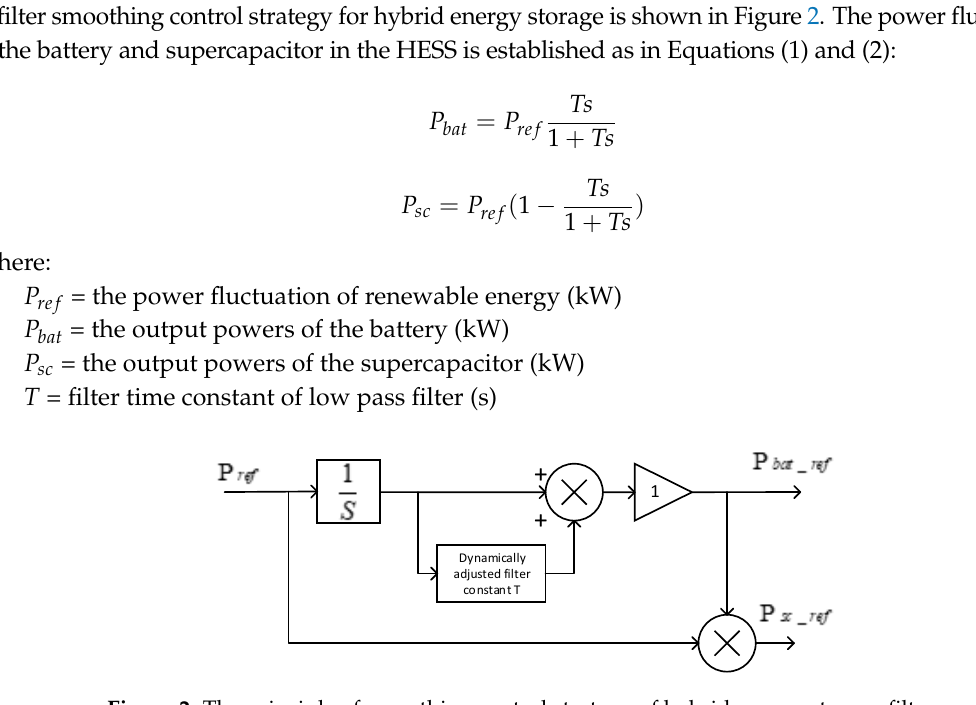
Figure 2. The principle of smoothing control strategy of hybrid energy storage filter.